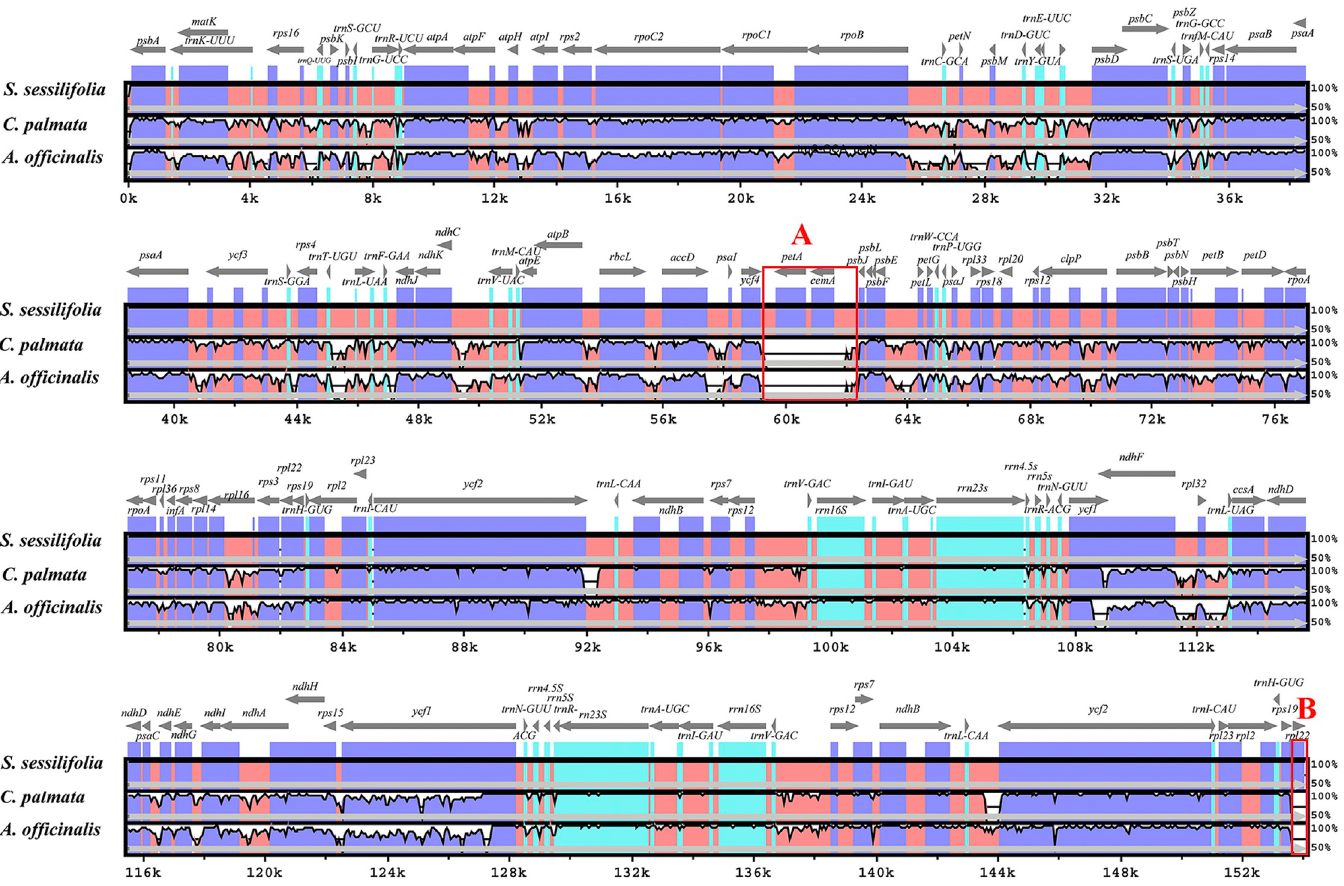
Fig 3. Comparison of the three chloroplast genomes using mVISTA program. The gray arrows indicate the orientations and positions of genes. Untranslated, conserved non-coding and coding regions were characterized by sky-blue, red and blue blocks, respectively. A cut-off value of 70% was adopted during the process of